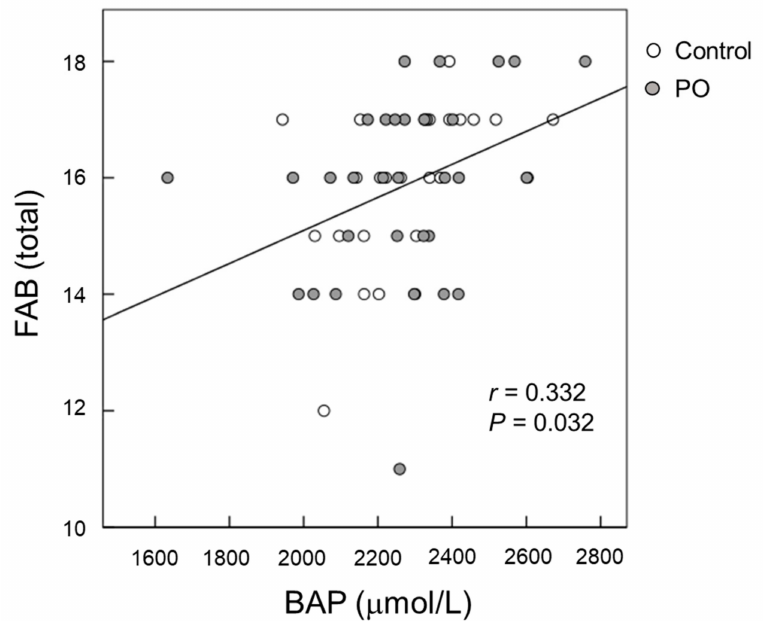
Figure 5. Scatter plot of the relationship between FAB scores and serum BAP at baseline. (Open circle) control group; (Grey circle) perilla seed oil-intake group. FAB, Frontal Assessment Battery; BAP, biological antioxidant